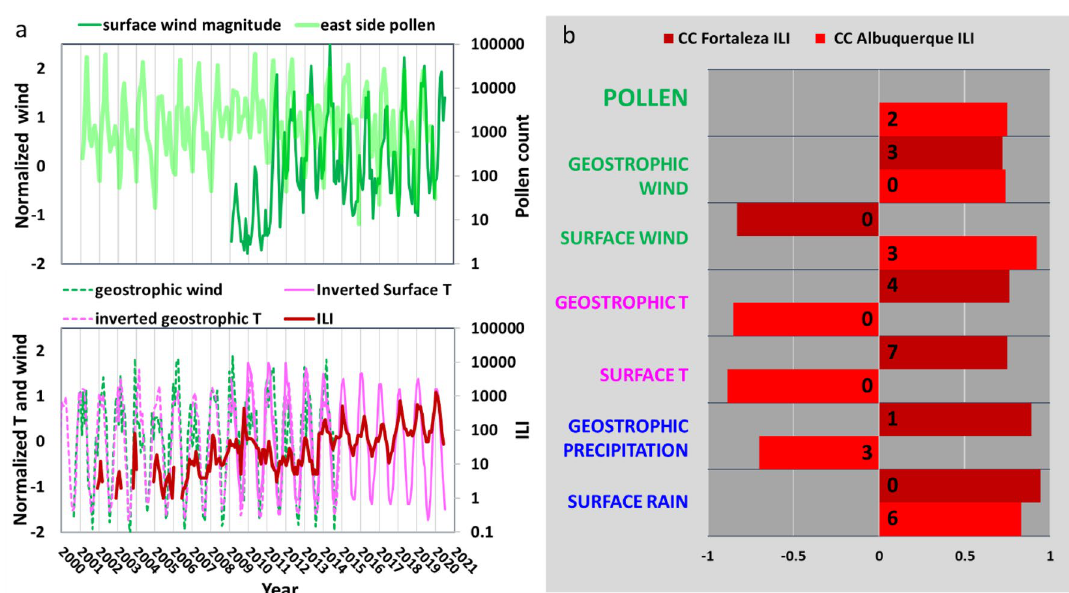
Figure 3. Time series and correlations of featured climatological variables and ILI. ( a ) Top panel: East Albuquerque pollen counts 31 and normalized surface winds 34 over the past two decades. Bottom panel: Albuquerque ILI count 30 and normalized geostrophic wind 35 , and geostrophic 35 and surface 34 temperature over the same time period. ( b ) Correlation coefficients (cc) of seasonal variables to Albuquerque ILI (bright red) and Fortaleza ILI (dark red). The Methods section in SI covers the general and geostrophic development of these